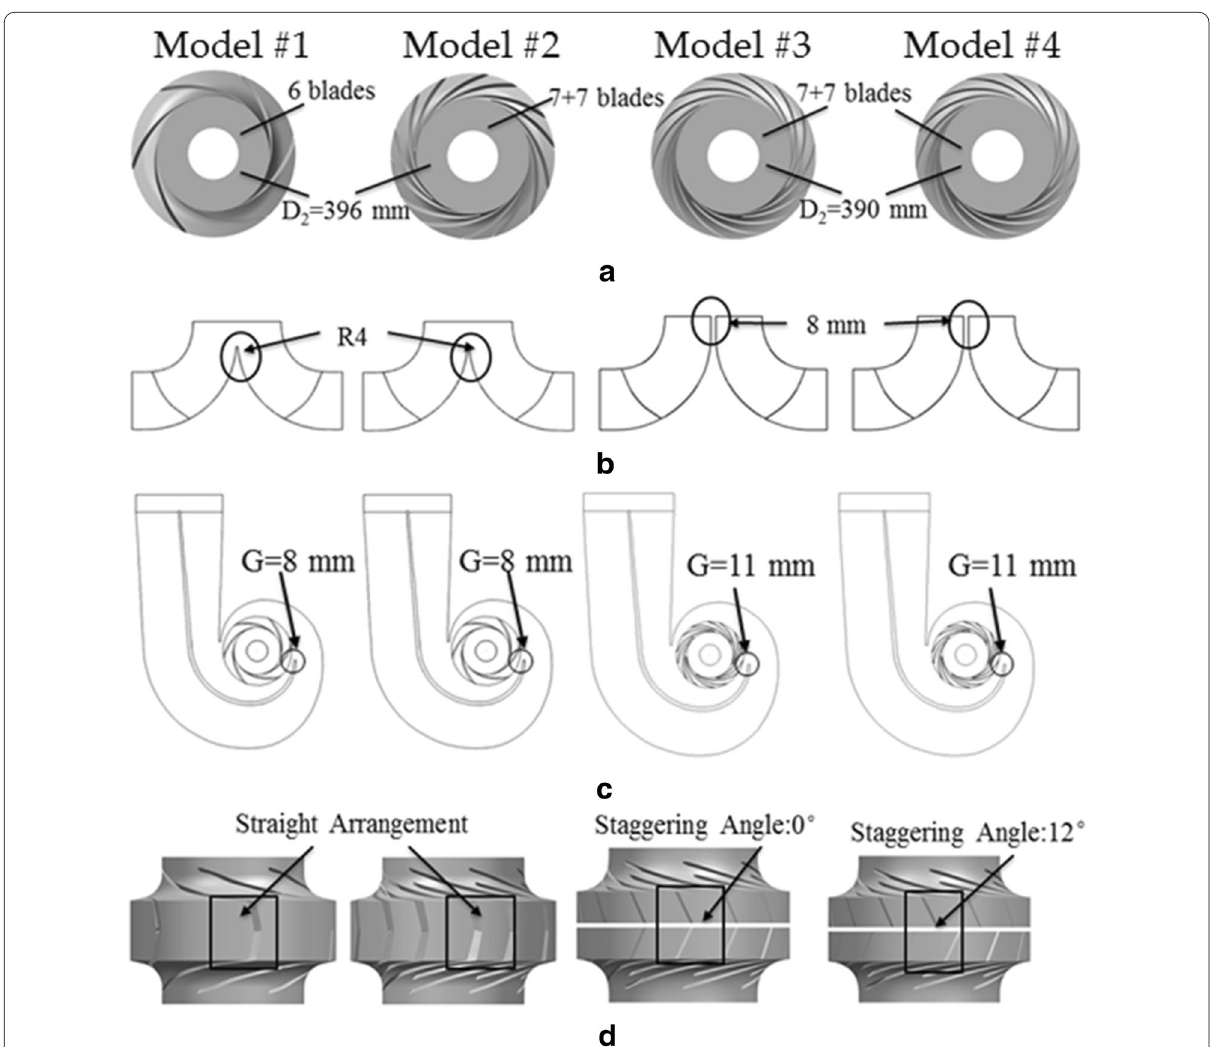
Figure 2 Redesign process of the four models: a Profile of the impellers; b Meridian surface of the impellers; c Gap between the impeller outlet and volute tongue; d Arrangement of the two-side